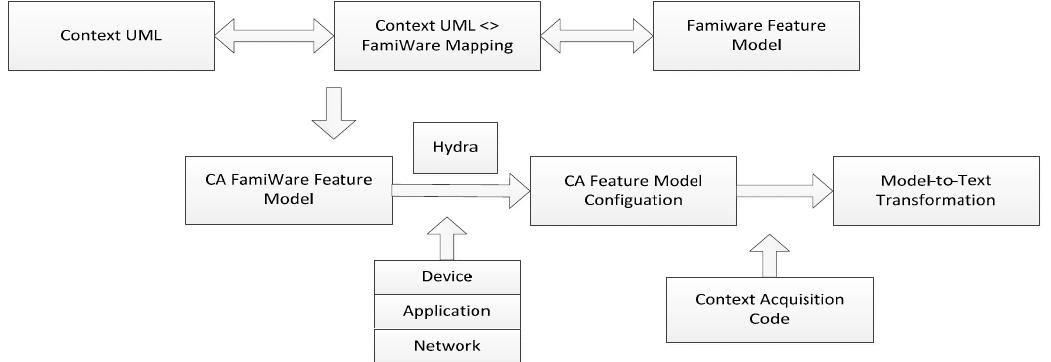
Figure 16. The illustration of FamiWare operations (adapted from [29,30]).